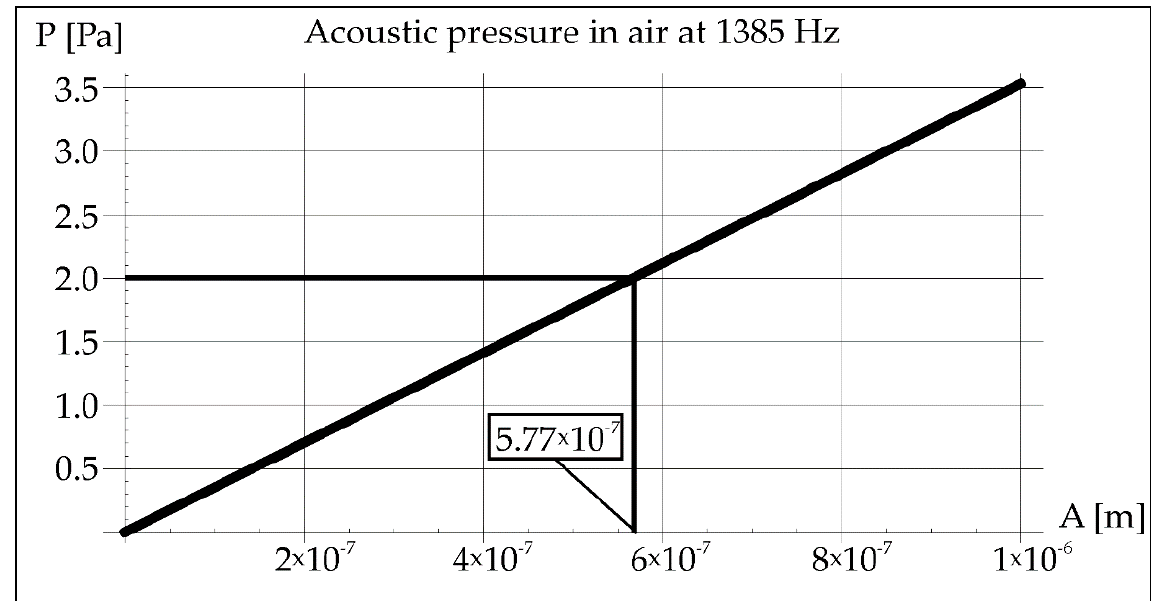
Figure 14. Acoustic pressure in air at resonance frequency 1385 Hz.